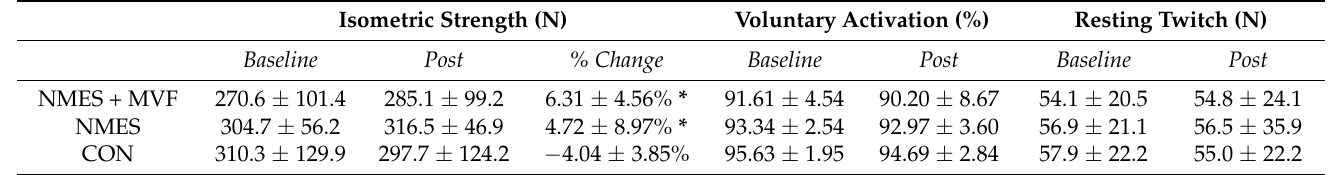
Table 2. Mean and standard deviation (SD) for the isometric strength, voluntary activation level, and resting twitch of the dominant (trained) elbow flexor muscle for all groups. Isometric Strength